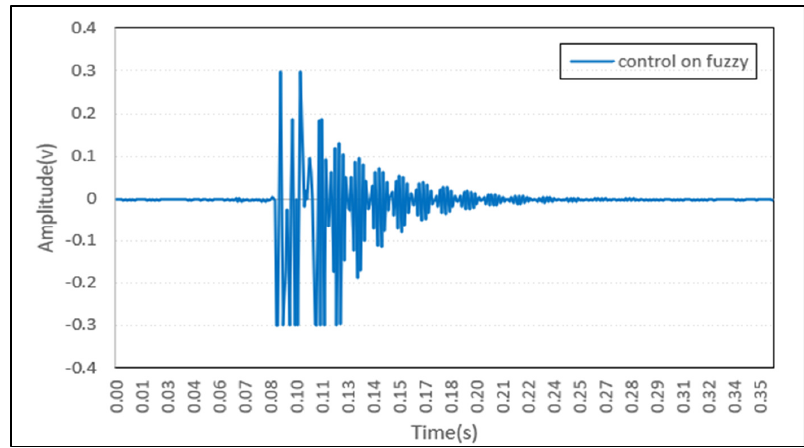
Fig. 9. Vibration Suppression and Time Response under FLC for the First